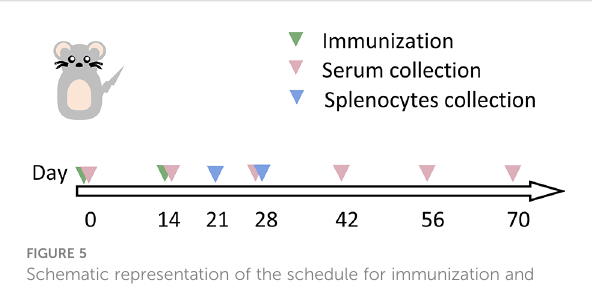
FIGURE 5 Schematic representation of the schedule for immunization and immunological characterization of the different immunization regimens. Mice were immunized with two doses of vaccine (as indicated in Table 1), and serum and splenocytes were collected at the indicated time points. NC, negative control; PBS, phosphate- buffered saline; Ad5, replication-defective human type 5 adenovirus- vectored